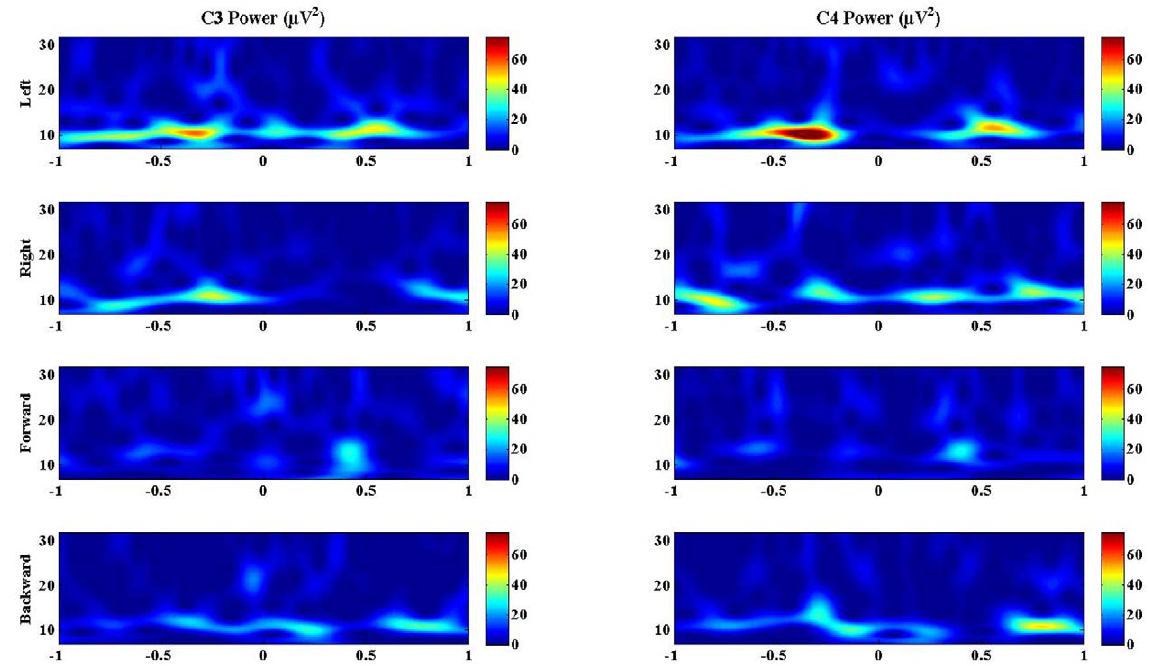
Figure 4. Time-frequency analysis shows averaged power distributions across time and frequency for representative control electrodes during segments of single direction control for subject number 3. Electrode C3 is on the left scalp hemisphere and electrode C4 is on the right. At time 0, the subject moved the helicopter in primarily one direction for .5 s. When a right turn is made, C3 shows ERD and C4 shows ERS. The opposite is true for a left turn. When both hands are imagined, both electrodes show periods of desynchronization, while the rest state results in both electrodes exhibiting synchronization. These changes in the time-frequency profiles may be leveraged to control two-dimensions of movement with only hand imaginations and volitional